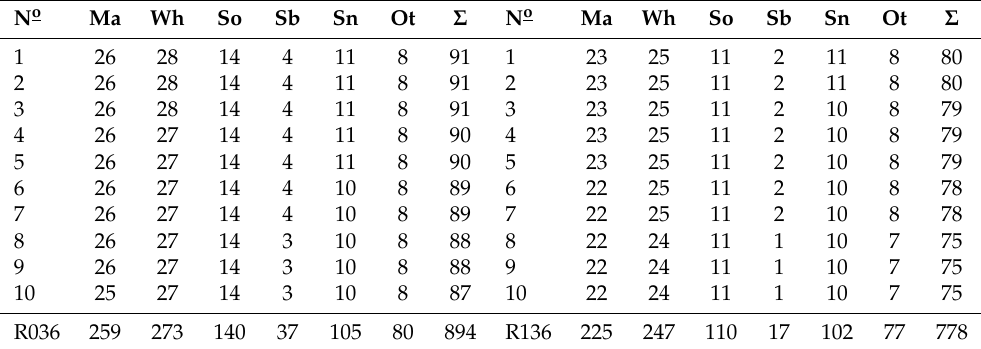
Table 2. Number of agricultural fields per each of the categories in 10-fold cross-validation of mapping experiments. Partition subsets, denoted by N o , consist of manually labeled crop fields from two different relative orbits in Figure 4, R036 and R136. Abbreviations: Ma-Maize, Wh-Wheat, So-Soybean, Sb-Sugar beet, Sn-Sunflower, Ot-Other.